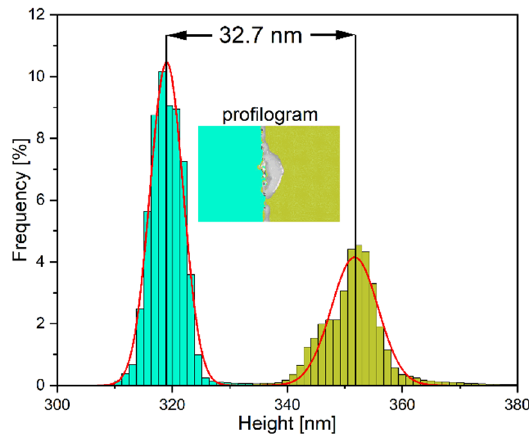
Figure 2. Height histograms received from the TiO 2 step, imaged by an optical profilometer. Bare FTO surface is represent by the cyan color and the thin film of TiO 2 is indicated by the olive color. The difference between the Gauss peak centers determines the layer thickness.